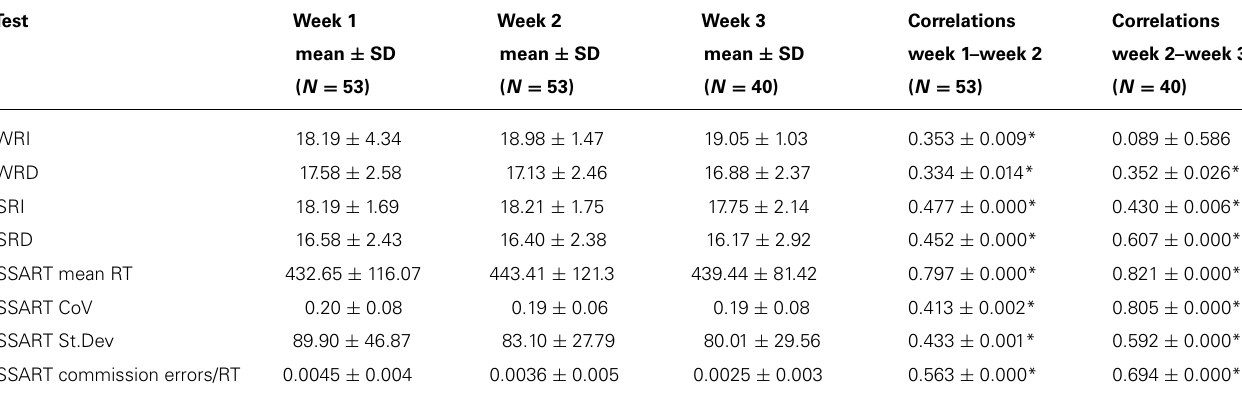
Table 2A |Test–retest reliability: spearman correlations between first and second and between second and thirdACAD administrations.